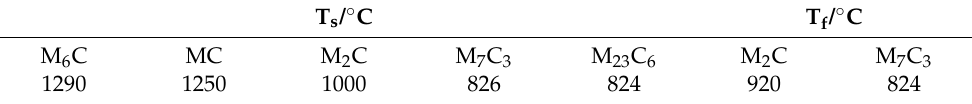
T s represents phase transformation starting temperature; T f represents phase transformation finish temperature. Ts represents phase transformation starting temperature; Tf represents phase transformation finish temperature.